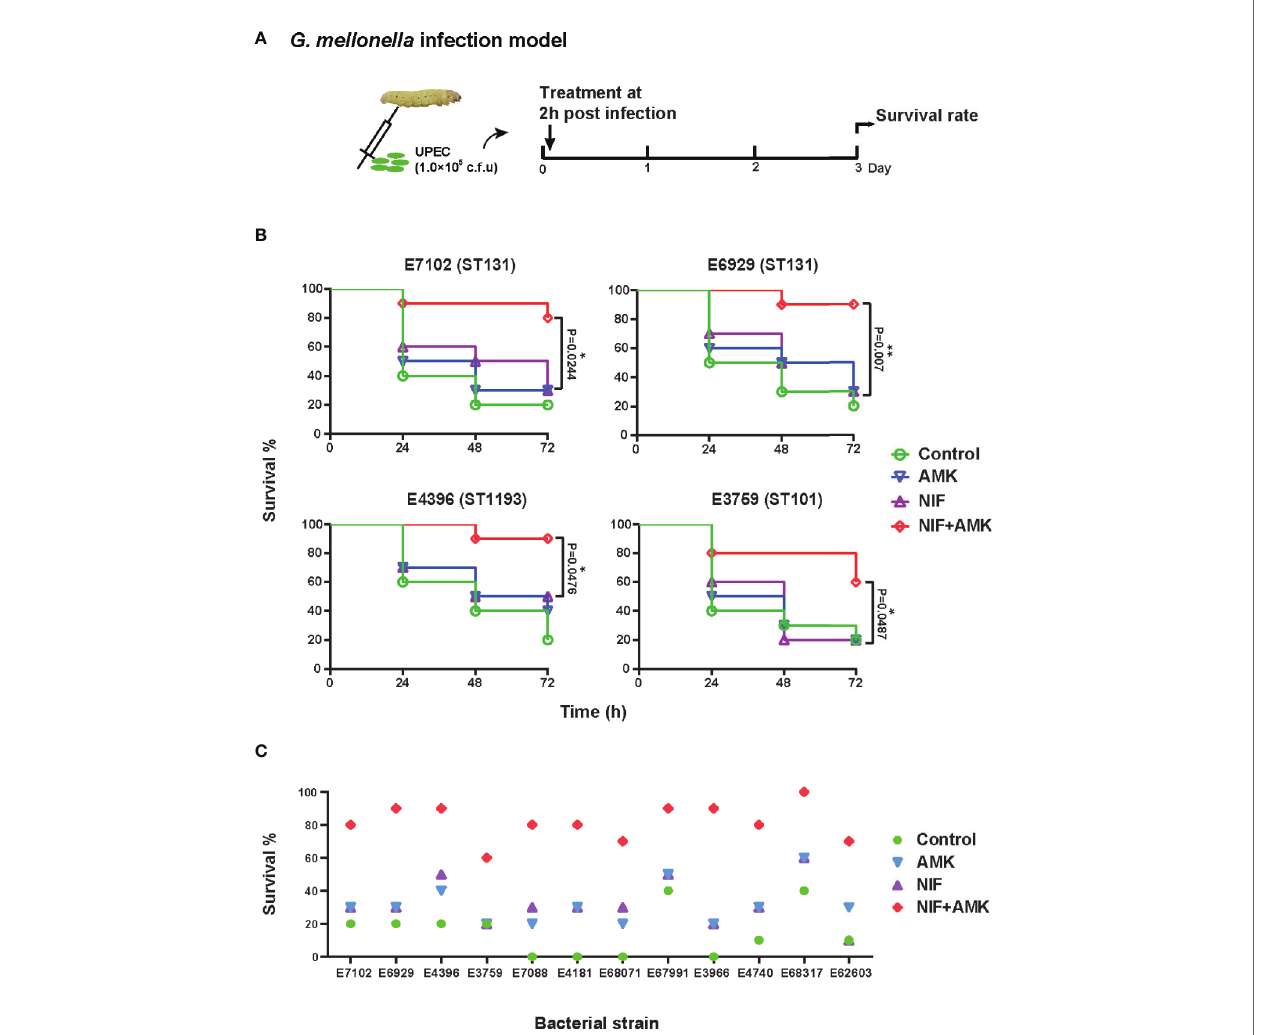
FIGURE 3 | Therapeutic effects of amikacin combined with nitrofurantoin in the G. mellonella model. (A) Scheme of the experimental protocol for the G. mellonella model. (B) Survival rates of amikacin and nitrofurantoin alone (most effective) and in combination treatment in an experimental G. mellonella model caused by the indicated UPEC strains. (C) Survival rates after 72 h caused by the indicated UPEC strains. ( ∗ ) p < 0.05 and ( ∗∗ ) p <